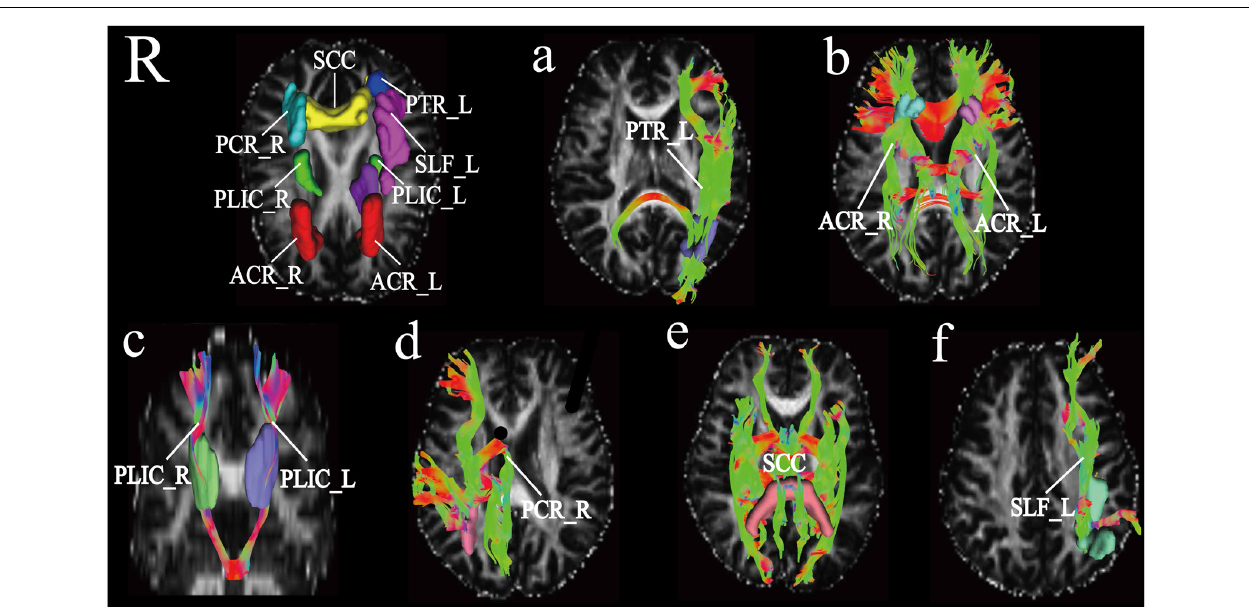
FIGURE 4 | Based on the JHU template, differential white matter fibers obtained from deterministic fiber tracking Panel (A) represents the white matter fiber PTR_L [the left of posterior thalamic radiation (include optic radiation)], (B) white matter fibers shown are ACR (anterior corona radiata), (C) white matter fibers shown are PLIC (posterior limb of internal capsule), panel (D) shows fibers as PCR_R (right posterior corona radiata), (E) SCC (splenium of corpus callosum), (F) SLF_L (left superior longitudinal fasciculus), respectively are shown in this